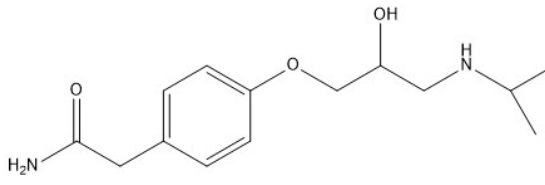
Figure 1. Structure of atenolol (ATL).